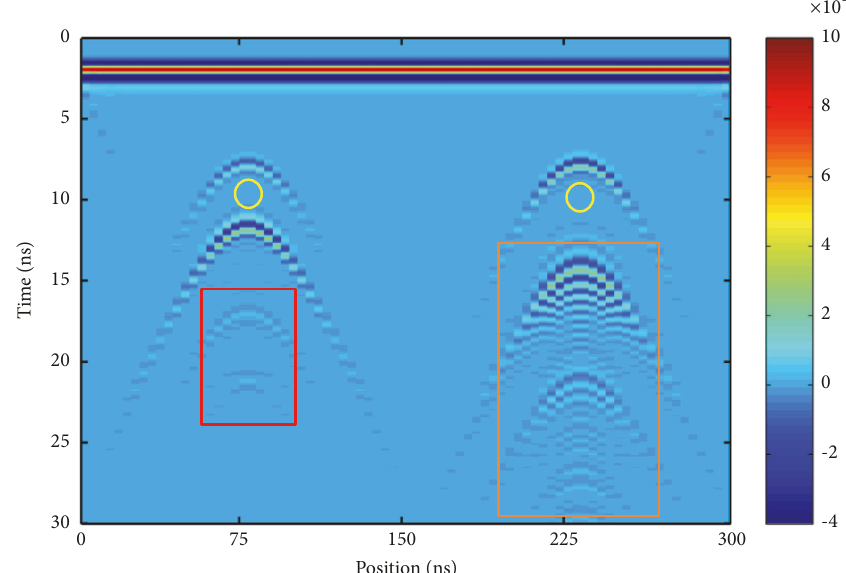
Figure 19: The wiggle trace profile of the underground pipes model simulated by the CUDA-implemented nonconformal SPRK methods.